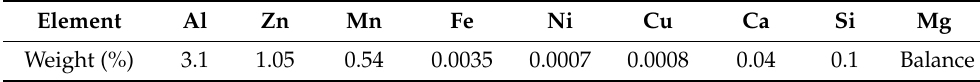
Table 1. Typical AZ31B chemical composition.